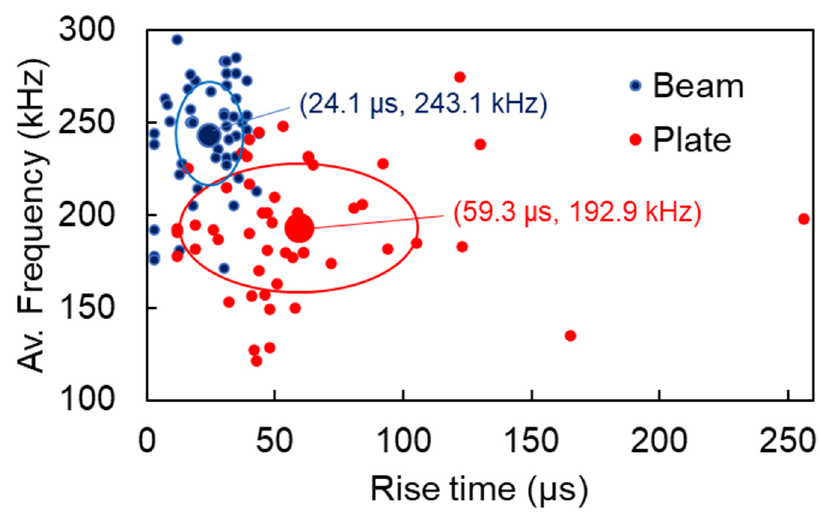
Figure 11. Average frequency vs. rise time of matrix cracking signals for a curved beam and a curved plate specimen. The large symbols denote the centers of the two populations. The axes of the ellipses are equal to the standard deviation (horizontal: rise time; vertical: average frequency).